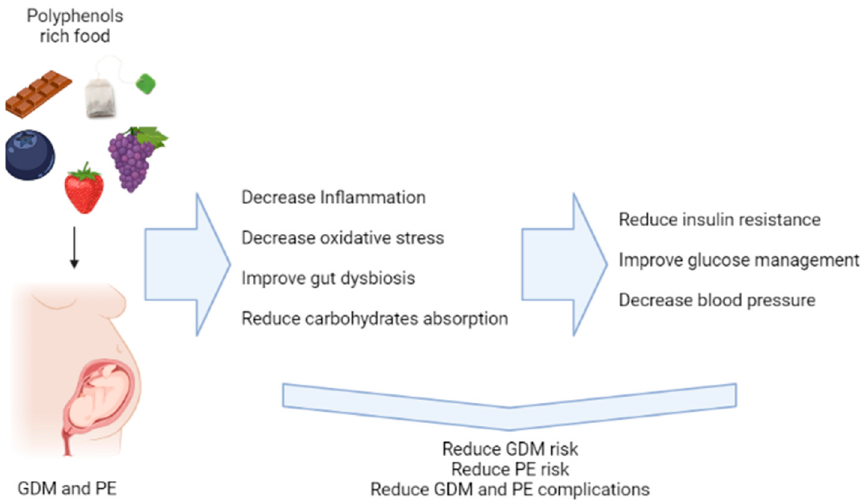
Figure 4. Scheme with potential role of polyphenol-rich foods against GDM and